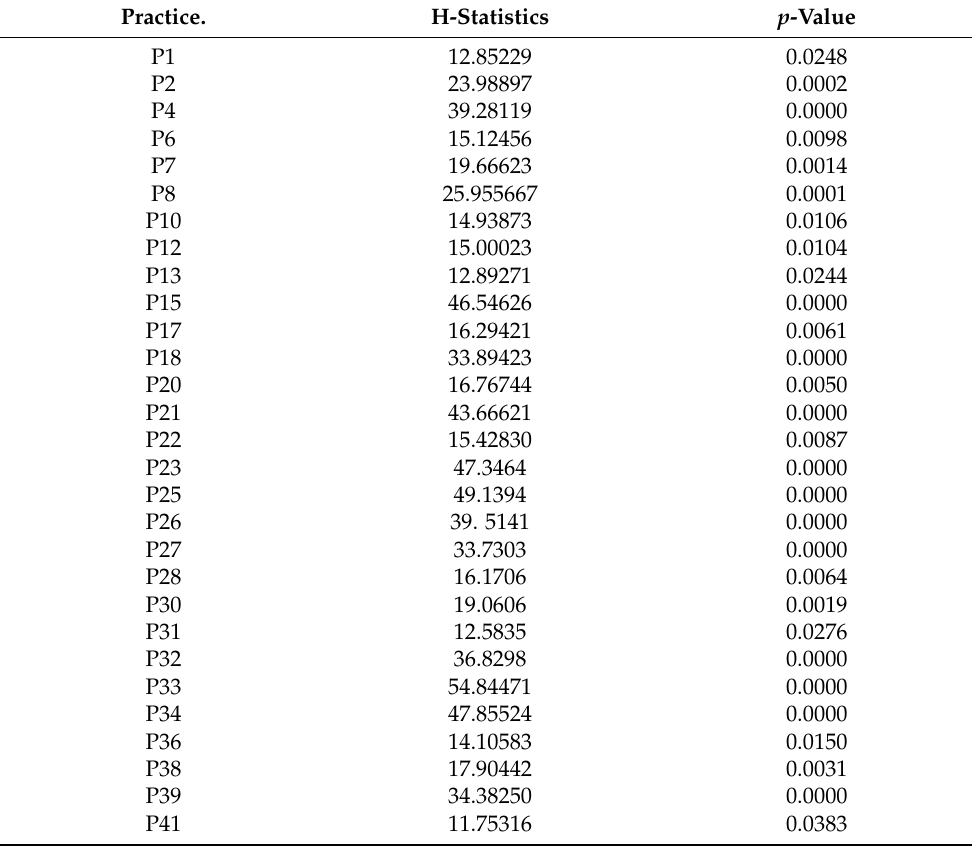
Table 6. The results of calculating the Kruskal–Wallis statistics test the hypothesis about the influence of the region of residence on the frequency of using proecological behavior